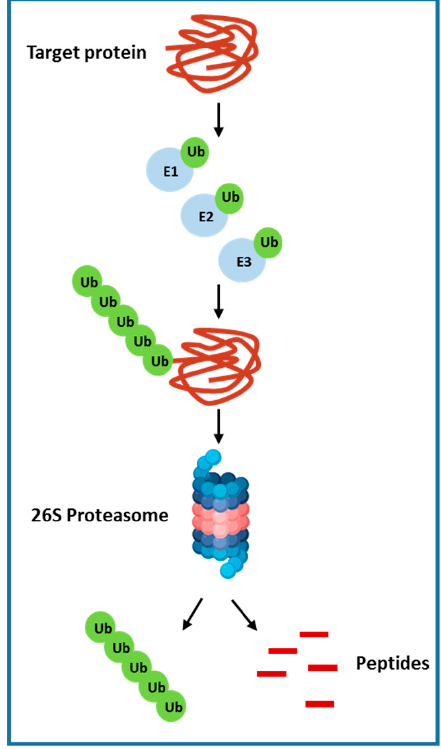
Figure 2. The Ubiquitin proteasome pathway.